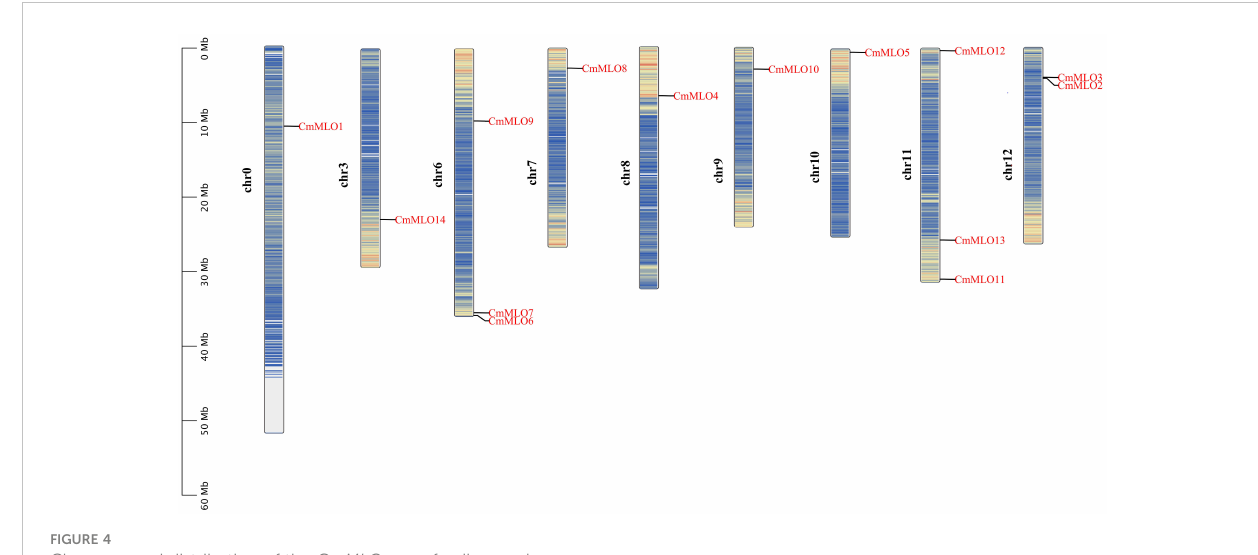
FIGURE 4 Chromosomal distribution of the CmMLO gene family members.